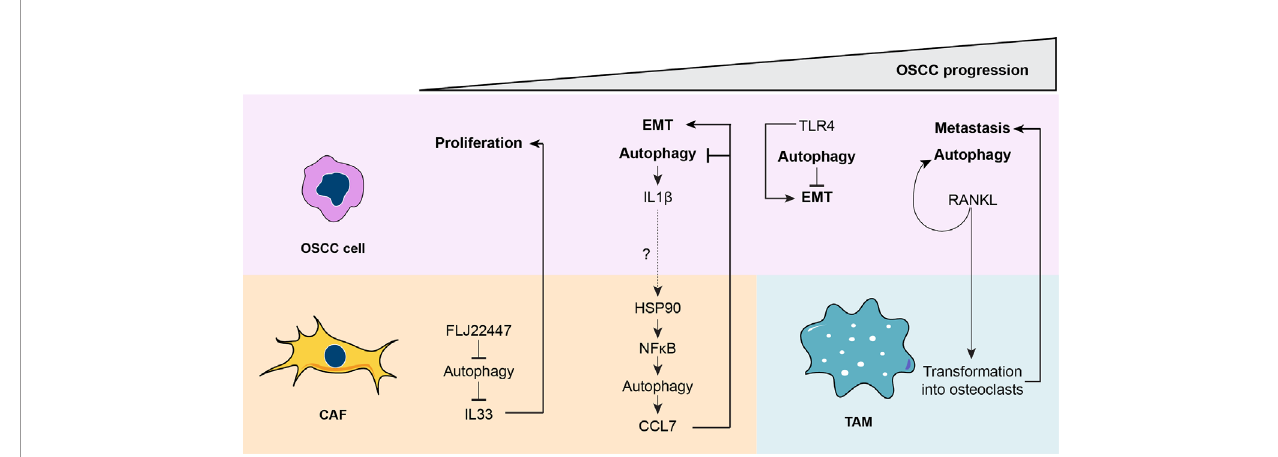
FIGURE 4 | A uni fi ed model for the role of autophagy during oral squamous cell carcinoma (OSCC) progression. During the early stages of OSCC, the long non- coding RNA FLJ22447 inhibits autophagy in cancer-associated fi broblasts (CAFs), impairing the autophagic degradation of IL33. Increased levels of IL33 are released from CAFs, inducing proliferation of the OSCC cells. Then, OSCC cells increase autophagy that releases interleukin-1 b (IL1 b ), which then increases autophagy in CAFs through an nuclear factor k B ((NF k B)-dependent mechanism. The IL1 b released from the OSCC cells may promote activation of heat shock protein 90 (HSP90) in the CAFs to increase NF k B activity, but this needs to be demonstrated (dashed line). However, it is known that NF k B-dependent autophagy in CAFs induces release of chemokine (C-C motif) ligand 7 (CCL7), which acts on OSCC cells, promoting epithelial-mesenchymal transition (EMT) and inhibiting autophagy. During later phases of OSCC, autophagy reduces Toll-like receptor 4 (TLR4)-dependent EMT. Therefore, inhibition of autophagy by CCL7 may promote TLR4-depedent EMT. Finally, during the advanced stages of OSCC, receptor activator of nuclear factor k B ligand (RANKL), which induces autophagy in OSCC cells, is released from OSCC cells transforming tumor-associated macrophages, TAMs, into osteoclasts, ultimately inducing